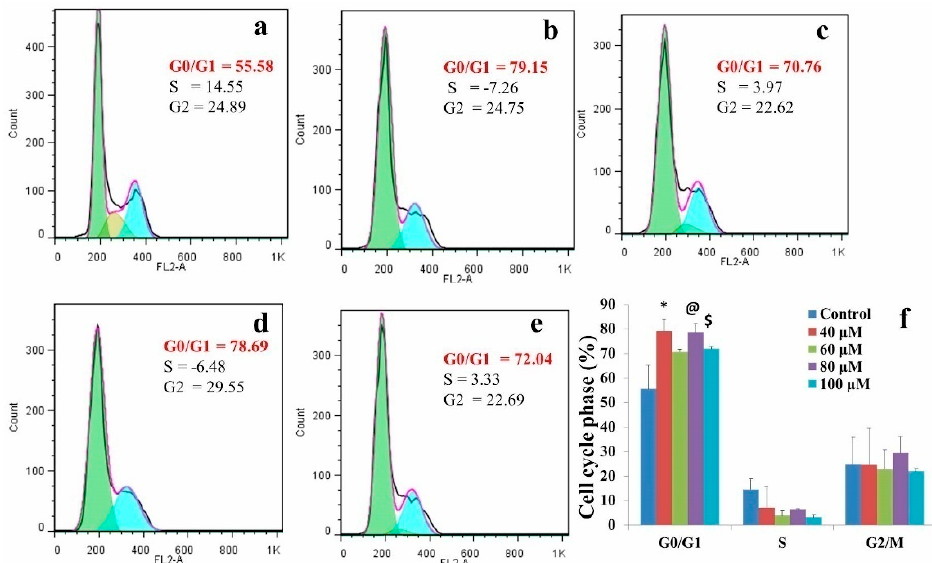
Figure 1. EGCG induced arrest at the G0/G1 phase of the cell cycle in A549 cells. ( a ) Untreated control ( b ) 40 μ M EGCG treatment ( c ) 60 μ M EGCG treatment ( d ) 80 μ M EGCG treatment and ( e ) 100 μ M EGCG treatment ( f ) the cell cycle distribution analysis. The data are shown as mean ± SD. Significant ( p < 0.05) difference between the groups are indicated by: “ ∗” between untreated control and 40 μ M EGCG treatment, “@” between untreated control and 80 μ M EGCG treatment, and “$” between untreated control and 100 μ M EGCG treatment.